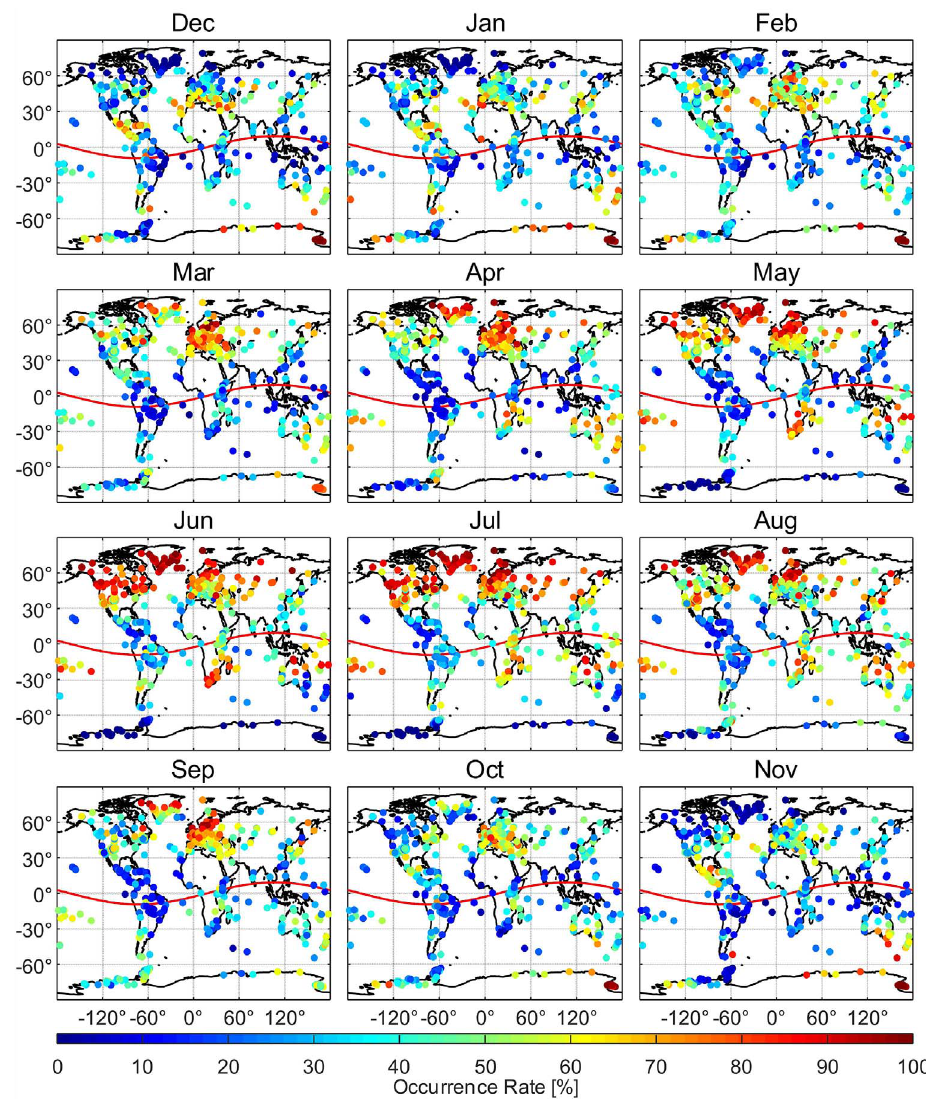
Figure 6. The occurrence rate of DDMs in each month at each station. The solid red line in the fi gure represents the magnetic equator.